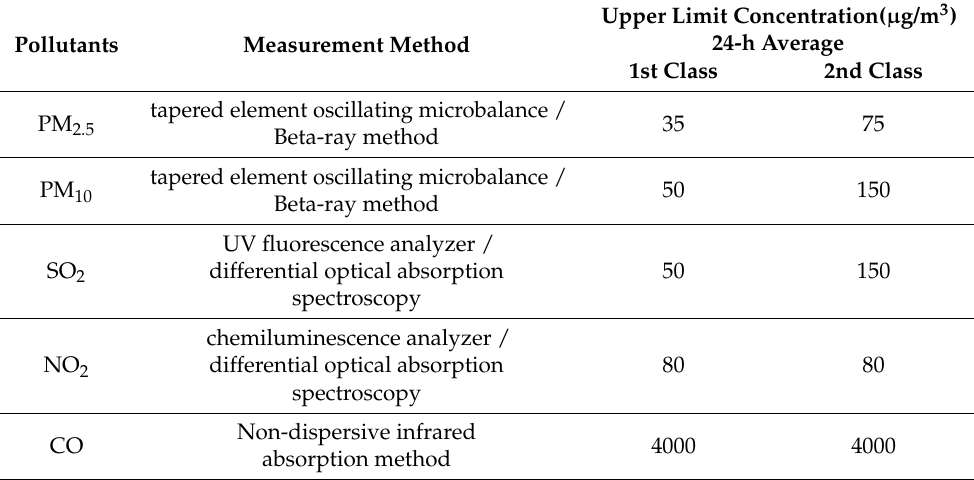
Table 1. Measurement methods and the upper limit concentrations of